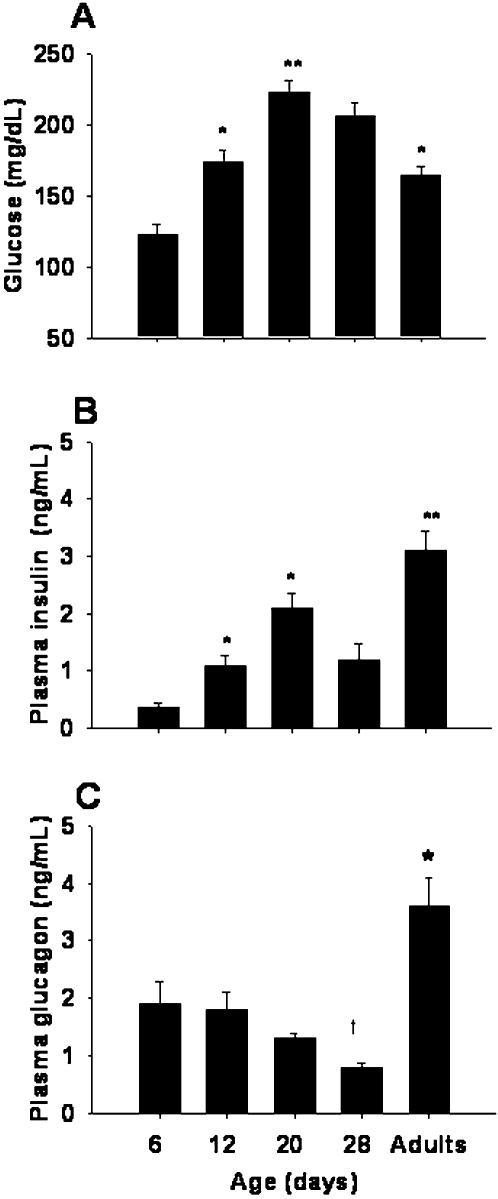
Plasmatic glucose and hormone levels at different ages.
(A) Glucose concentration (n  =  12 animals/point); (B) plasma levels of insulin (n  =  12), and (C) plasma levels of glucagon (n  =  6).Symbols denote statistically significant differences, (*) p<0.05 and (**) p<0.0001 with respect to previous age, (†) p<0.05 with respect to d6.